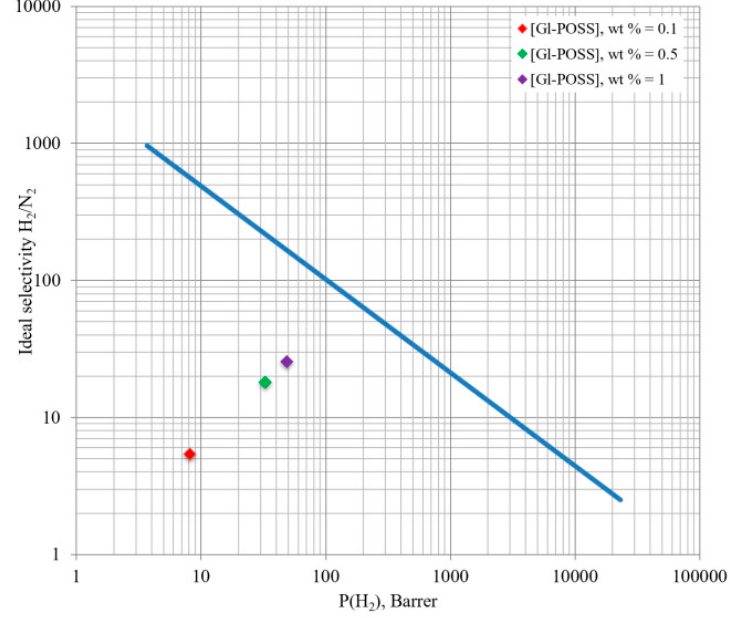
/ N 2 separation [78] and experimental